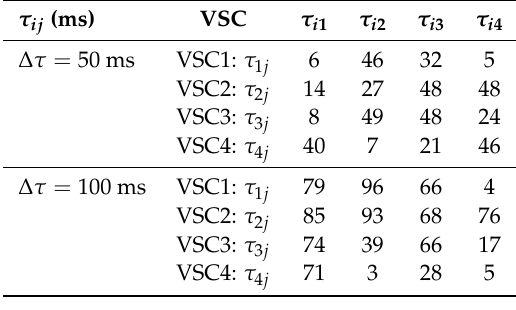
Table 4. Case C. Communication delays used ( τ ij (ms)).